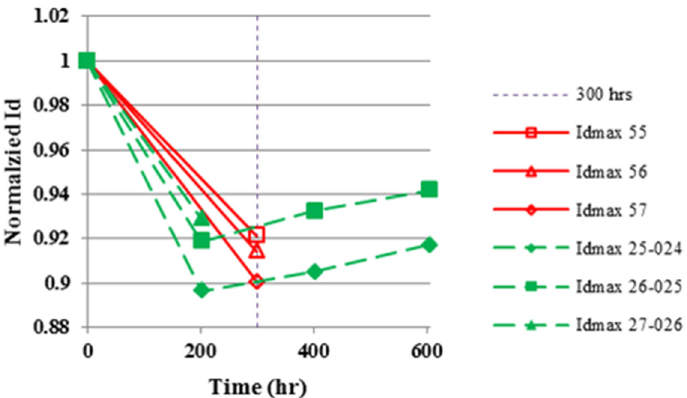
Figure 6. Normalized values (to the 0 h, 70 °C measurements) of maximum drain current ( I Dmax ) over time during the 300-h test, Condition 1 (lines 2–4 in the legend in red) and the 600-h test, Condition 6 (lines 5–7 in the legend in green) tests.